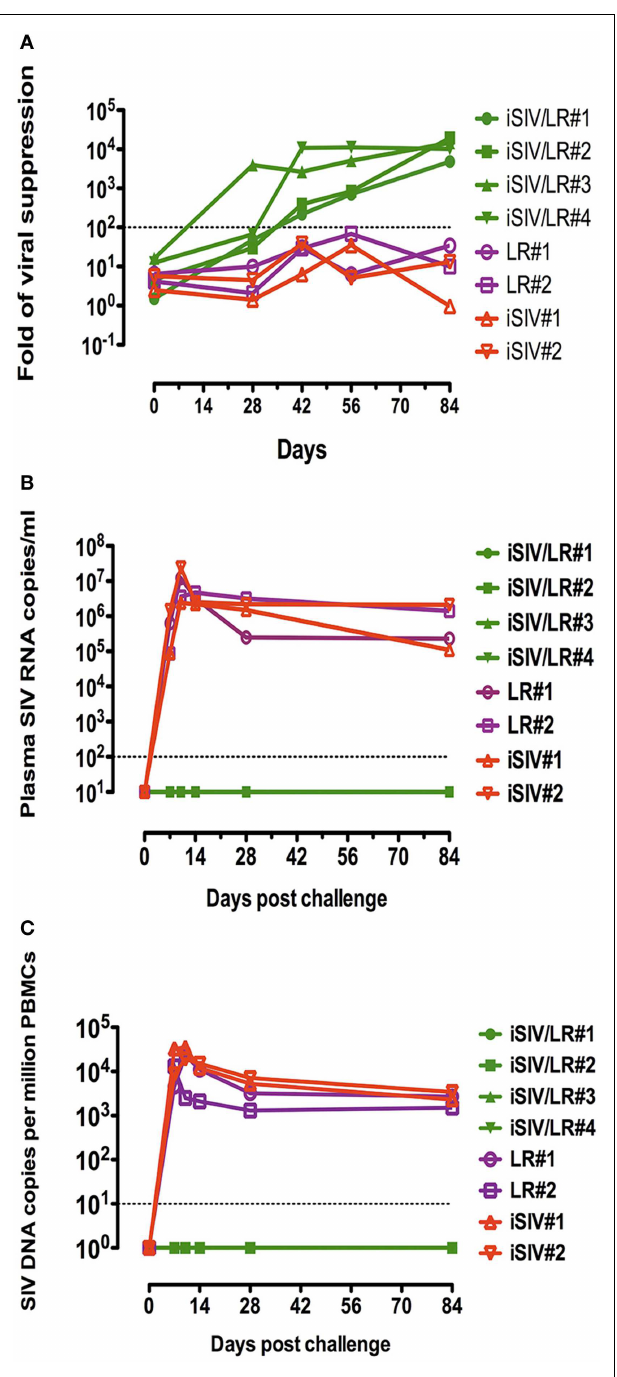
FIGURE 4 | Ex vivo antiviral activity induced by CD8 + T-cells of four macaques intragastrically immunized with iSIV plus LR and viral loads of the four macaques following an intrarectal challenge . (A) Ex vivo antiviral activity induced by CD8 + T-cells of four macaques intragastrically immunized with iSIV and LR and four control monkeys immunized with iSIV alone or LR alone; (B,C) plasma viral loads (B) and PBMC proviral loads (C) following an intrarectal challenge performed intrarectally with SIVmac239 (100,000TCID50) at day 90